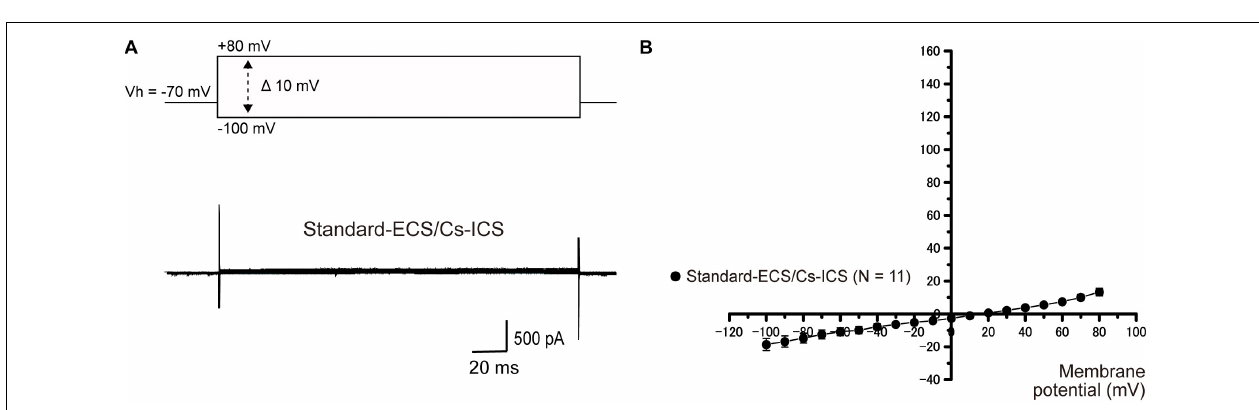
Frontiers in Physiology |